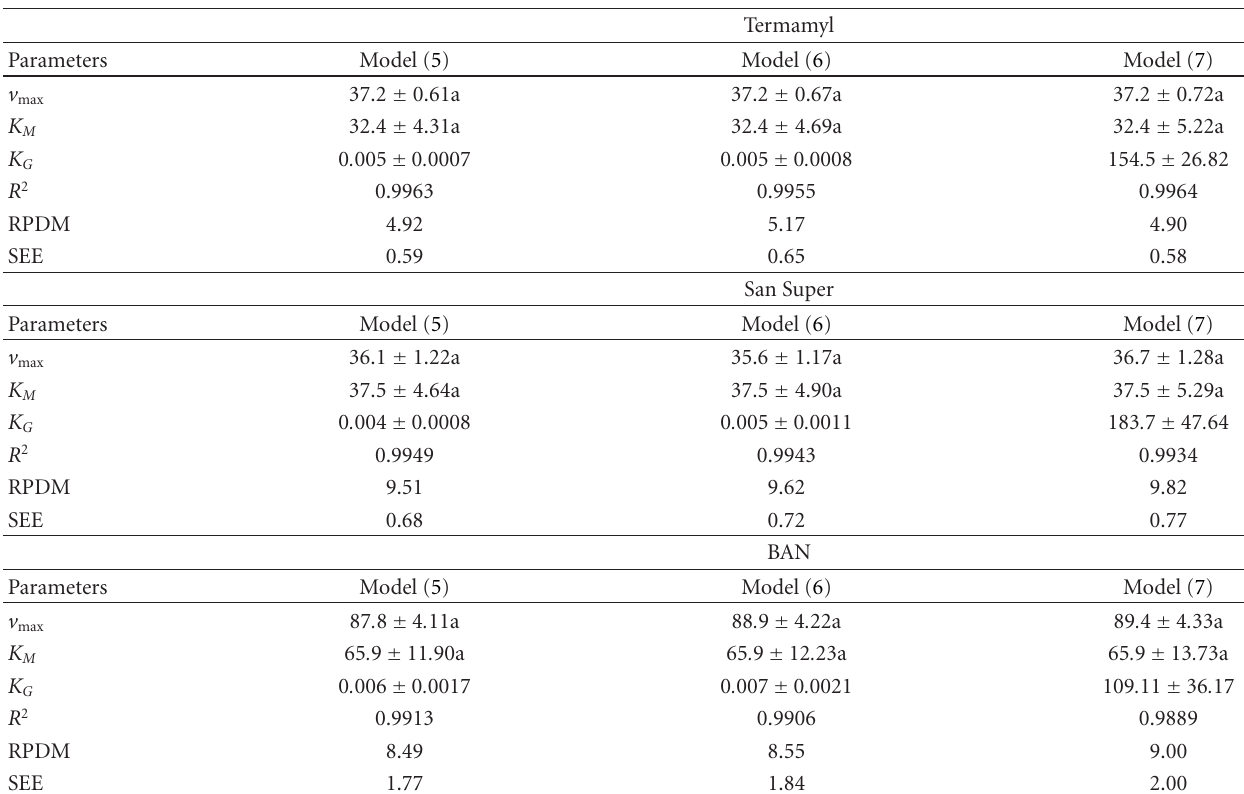
Figure 7: Response surfaces plot showing the e ff ect of the concentrations of starch [ S ] and gelatine [ G ] on the amylolytic activity ( v ) of the three enzymes. Table 5: Statistically significant ( P < 0 . 05) values (means ± standard errors) of the parameters in the overall modified Michaelis-Menten models (5), (6), and (7) for the enzymatic reactions of the three amylolytic enzymes in starches mixed with di ff erent initial gelatine [ G ] concentrations (0, 25, 50, and 75g/L). The mean values within rows followed by the same letter are not significantly di ff erent ( P < 0 . 05) from each other. SEE: Standard error of estimate of the